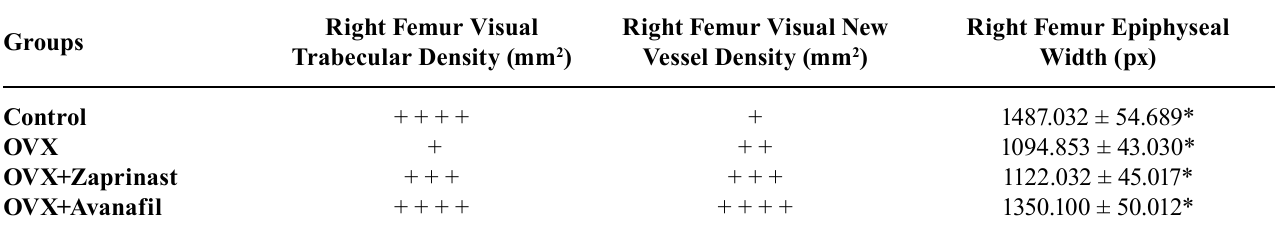
TABLE II – Comparison of right femur trabecular bone density, formation of new vascular structures and epiphyseal bone width in the all groups of rats with ovariectomy-induced osteoporosis